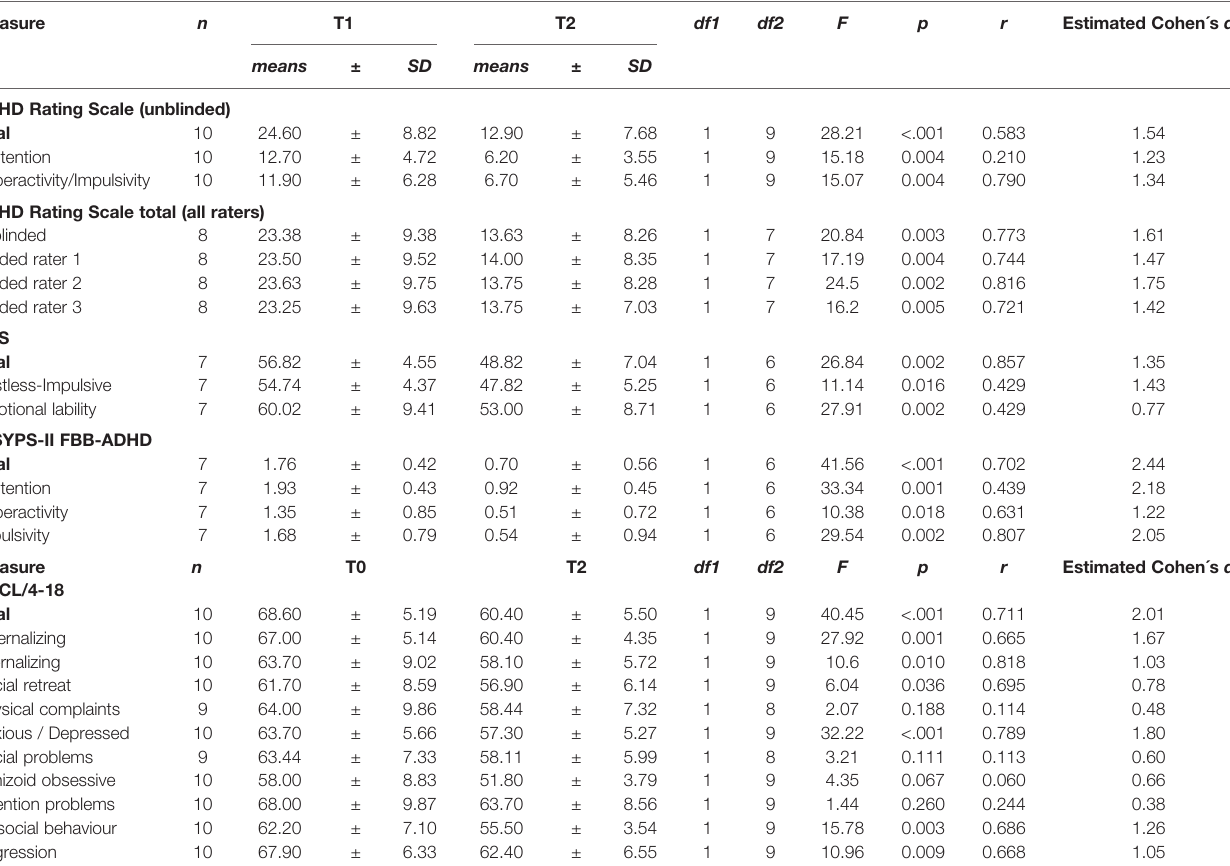
TABLE 4 | Results attention-de fi cit/hyperactivity disorder (ADHD) measures.